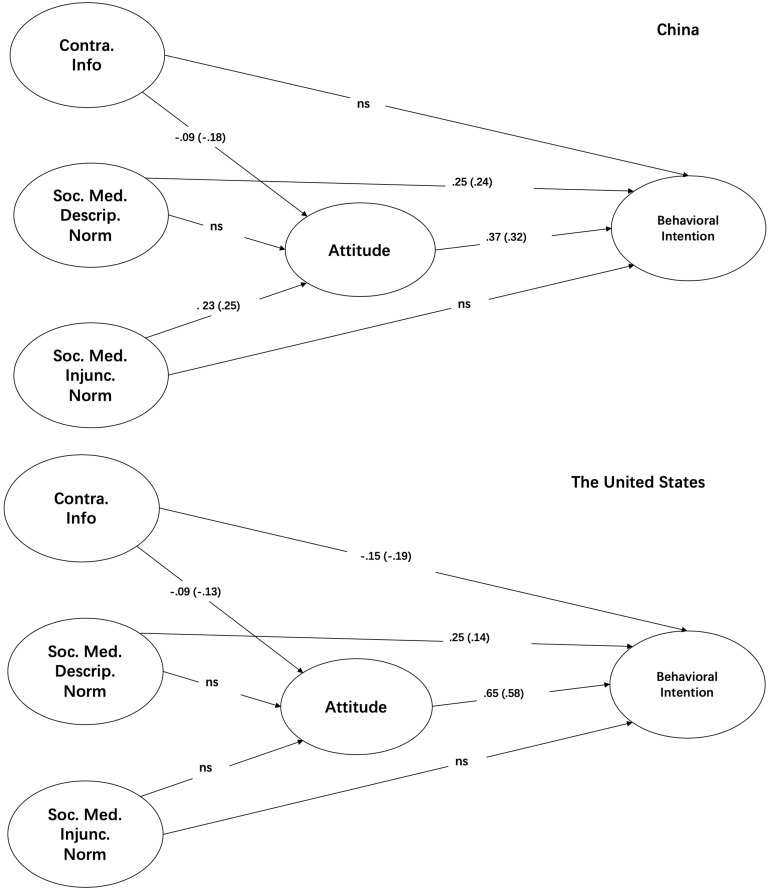
Multi-group SEM.